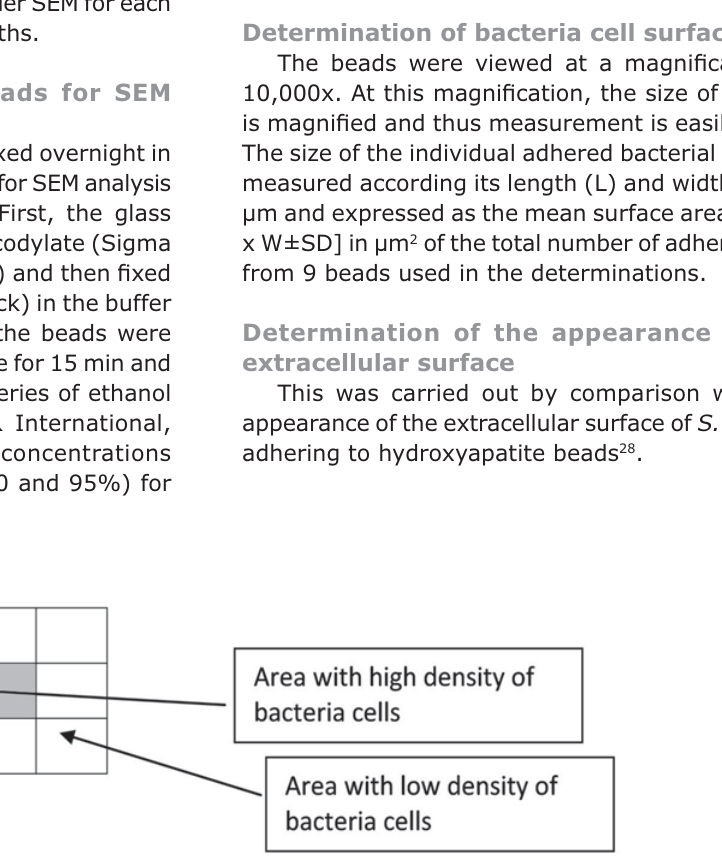
Figure 1- Diagram showing the calculation for the number of bacterial cells on 100 (cid:2) m 2 area in a total area of 1 mm 2 of the glass surface. The area with high density of bacteria cells was used in the calculation of the number of cells in Table